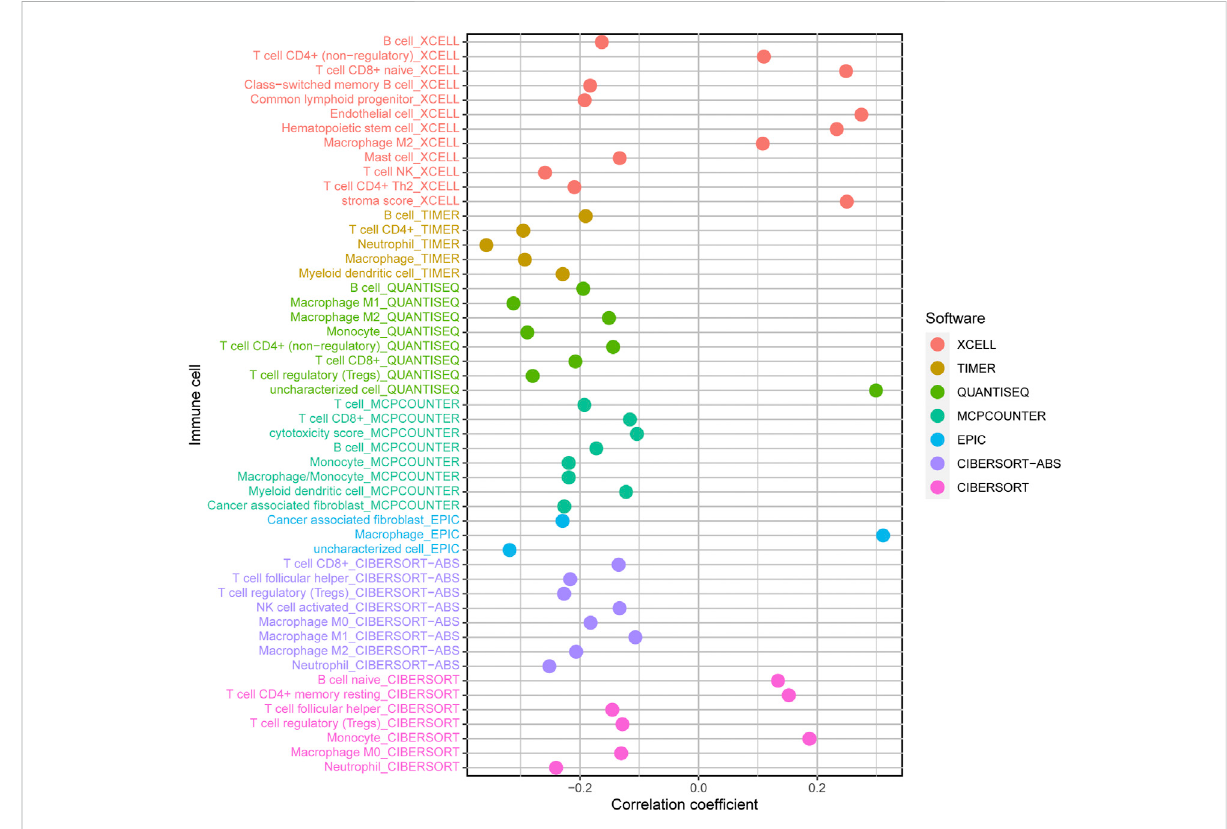
FIGURE 7 Correlations of LECT2 expression with immune in fi ltration level in